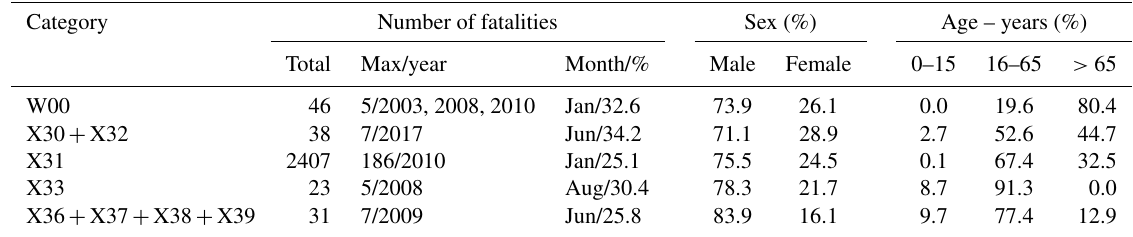
Figure 11. Characteristics of vehicle accident fatalities with regard to weather events (1 – rain and wet roads, 2 – glaze ice, 3 – snow, 4 – fog, 5 – other inclement weather) in the Czech Republic during the 2000–2019 period: (a) fluctuation with linear trend (top right, fatalities/10 years), (b) annual variation, (c) spatial distribution (21 fatalities lack exact locations), (d) part of the day, (e) age, (f) sex. For explanation of symbols and abbreviations see Fig. 1. Table 2. Number of fatalities and their features according to the Czech Statistical Office database in the 2000–2019 period: W00 – fall on ice or snow; X30 + X32 – excessive natural heat and solar radiation; X31 – excessive natural cold; X33 – lightning strike; X36 + X37 + X38 + X39 – avalanche, landslide or other earth movements, natural catastrophic storm, flood (inundation), and other and non-specified natural